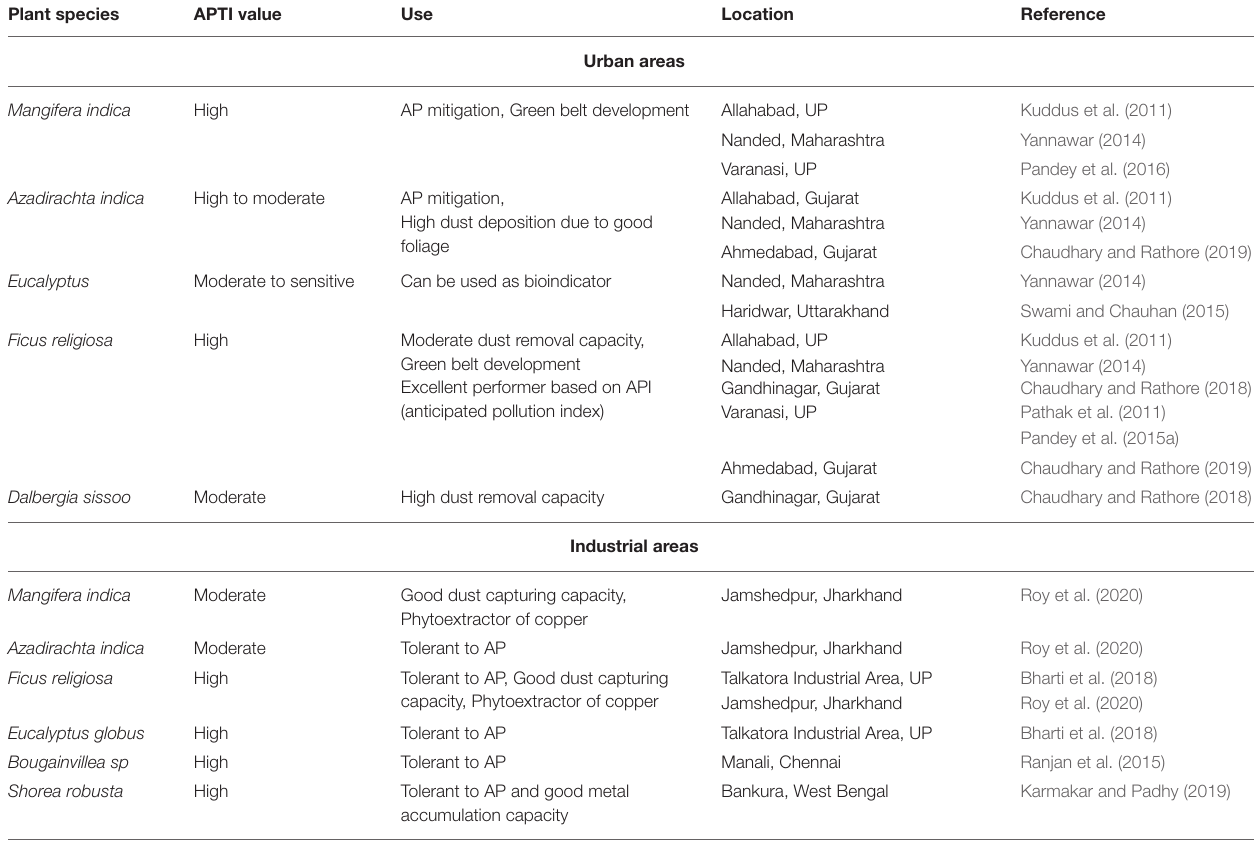
TABLE 2 | Air pollution tolerance and sensitivity of commonly studied plant species in Indian cities. Plant